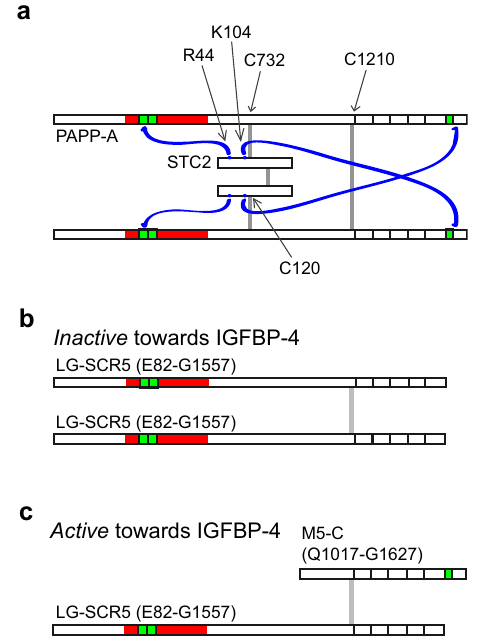
Fig. 9 | Trans dimerization of the PAPP-A dimer is maintained in the PAPP- A·STC2 structure. a Minimalistic schematic drawing of the PAPP-A·STC2 2:2 complexwithindicationoftheintersubunitdisul fi debonds(verticalgraybars)and observed(Cdomain-STC2)andhypothesized(LNR1-STC2)interactions(bluelines). The LNR modules are shown in green. Note that because the PAPP-A polypeptides cross at M6, LNR1 and LNR3 of each PAPP-A subunit do not interact with the same STC2 subunit. b Biochemical experiments have shown that PAPP-A subunits trun- cated before LNR3 are able to form dimers, but such dimers cannot cleave IGFBP- 4 18 . c Heterodimerization between the same subunit truncated before LNR3 and a C-terminal fragment of PAPP-A, which is truncated before M5, rescues the pro- teolyticactivitytowardIGFBP-4 18 ,thussuggestingthatPAPP-Aiscon fi guredintrans before it forms the complex with